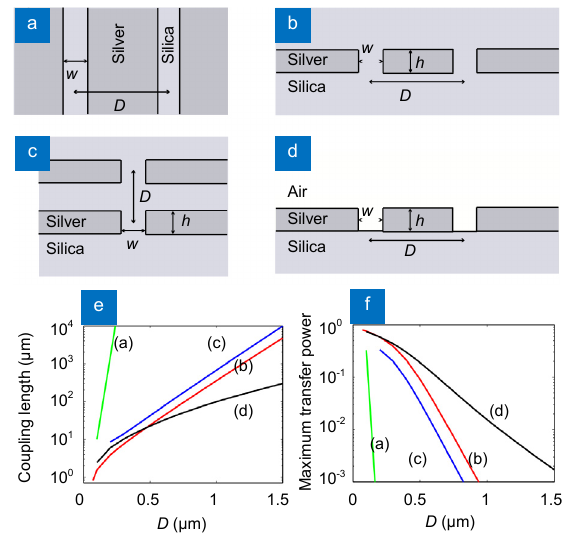
Fig. 1 | Four different waveguide schematics ( (a), (b), (c), (d) ) and the dependences of ( e ) coupling length L c and ( f ) maximum transfer power P max on separation distance D 23